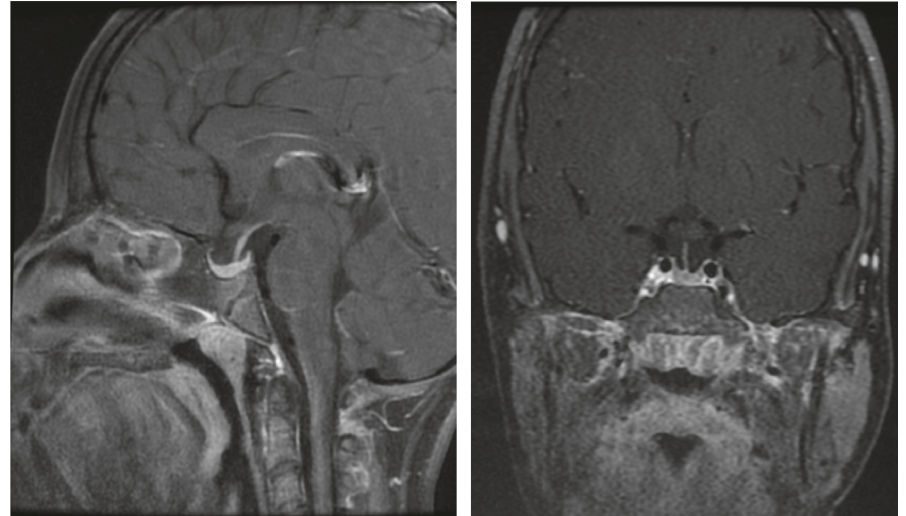
Figure 6: Sagittal and coronal contrast-enhanced T1-weighted magnetic resonance images taken after two years of follow-up. The images showed significant improvement of the pituitary mass as demonstrated by the marked reduction in size, returning to a normal